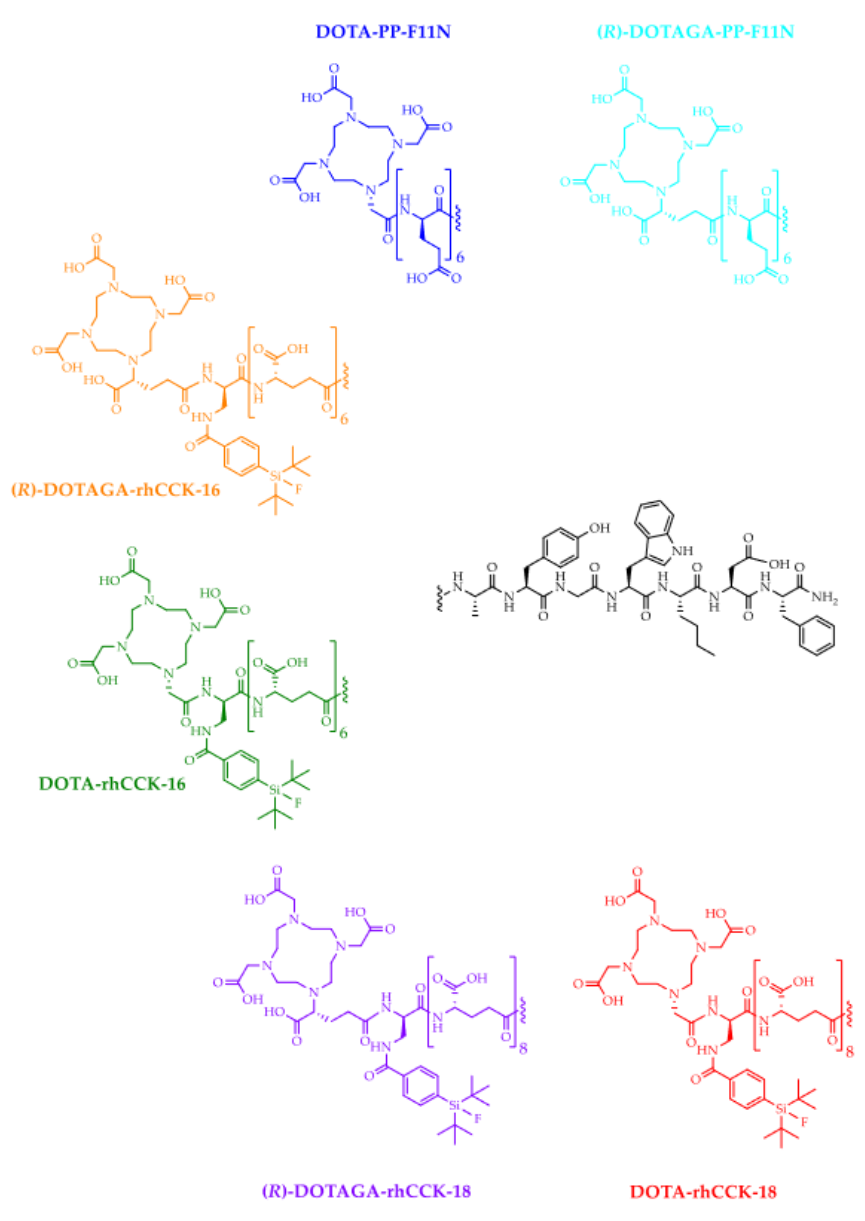
Figure 1. Chemical structures of the ( R )-DOTAGA- and DOTA-comprising minigastrin analogs evaluated in this study.